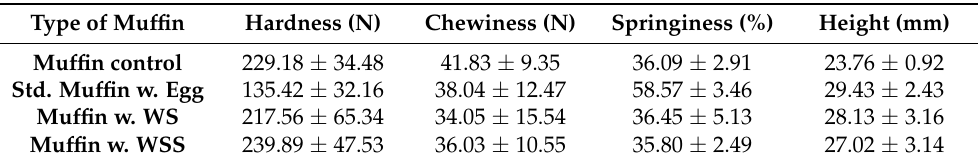
Table 8. Texture and height of chocolate muffins baked with WS, WSS or egg, n = 3. Control muffin has no egg.